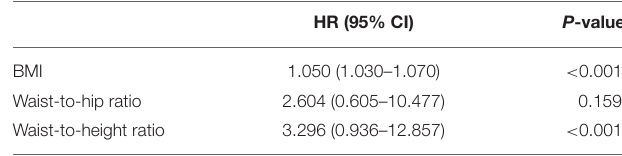
TABLE 2 | Cox regression analysis determining the association between BMI, waist-to-hip ratio, and waist-to-height ratio with incident hypertension during the follow-up period; results are adjusted for age, gender, history of CAD, SBP, DBP, FPG and family history of